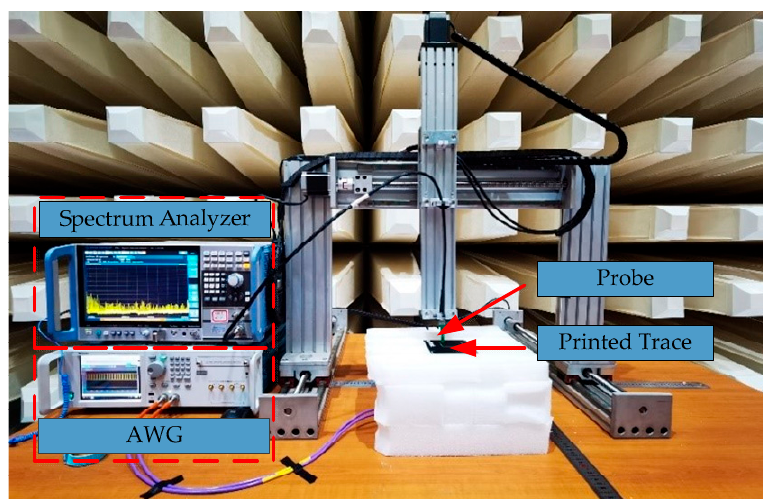
Figure 6. The setup for the transmission characteristics extraction